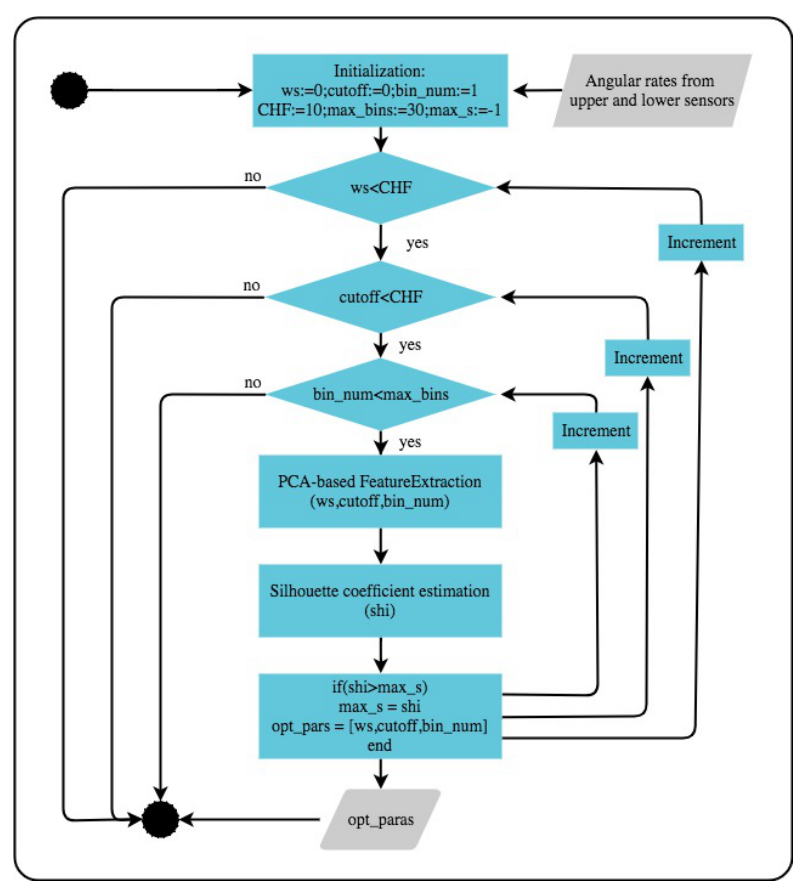
Figure 7. Optimisation for parameters